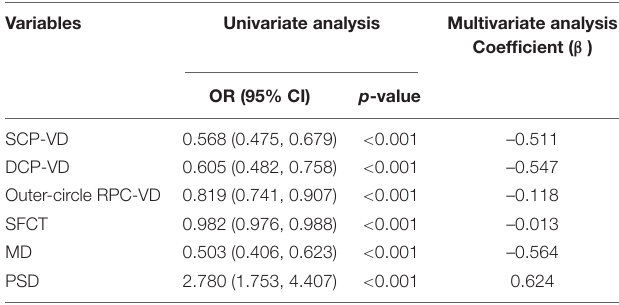
TABLE 3 | Logistic regression model analyses of associations between the retinal parameters and MDD. Variables Univariate analysis Multivariate analysis